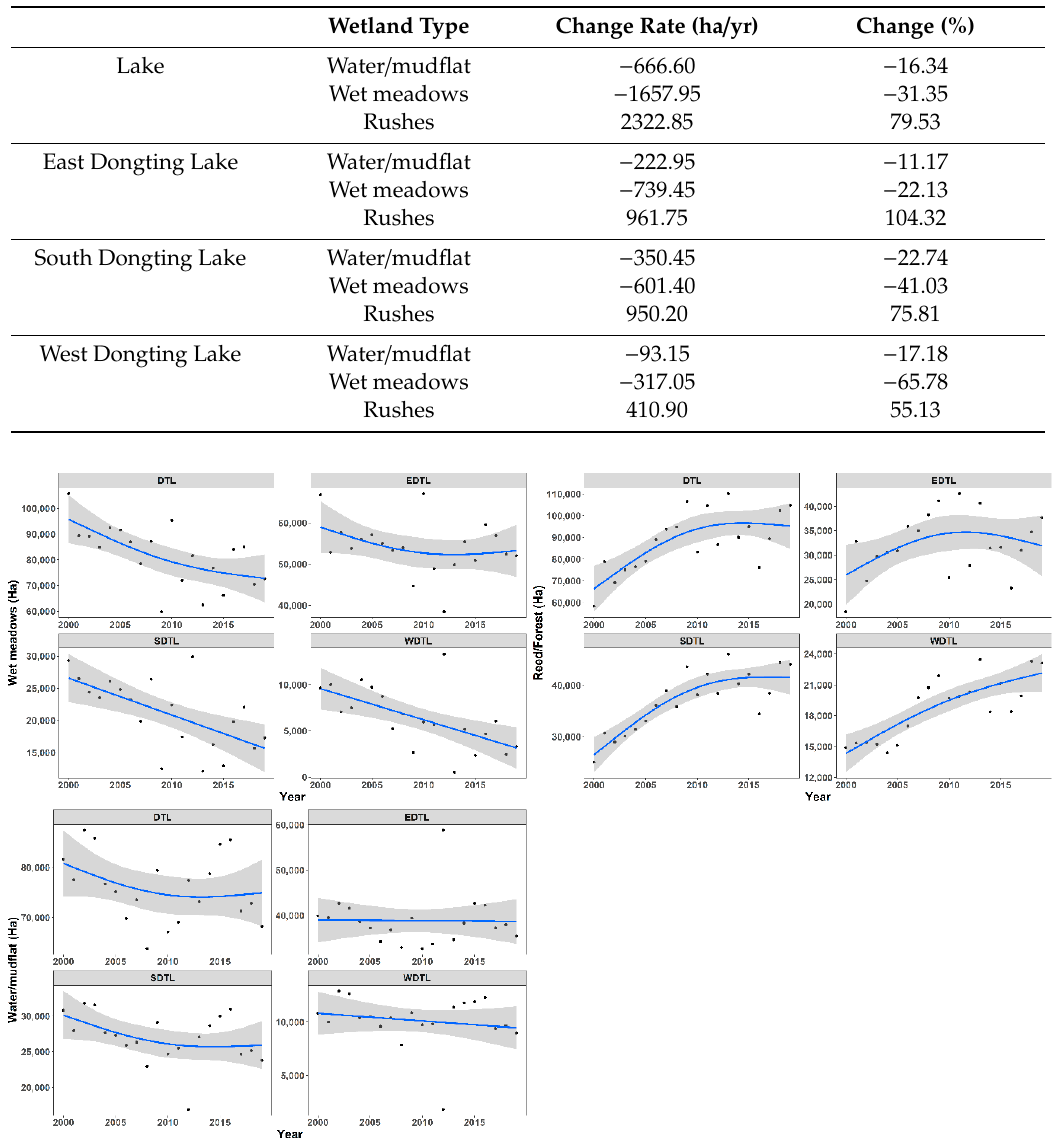
Figure 7. Wetland dynamics for the period of 2000–2019. Dots are mapped areas of water/mudflat, wet meadows, and rushes; lines are the gam (generalized additive model) smoothed trends, and the shaded areas are the 95% confident intervals. DTL = the entire lake, EDTL = East Dongting Lake, SDTL = South Dongting Lake, and WDTL = West Dongting Lake.